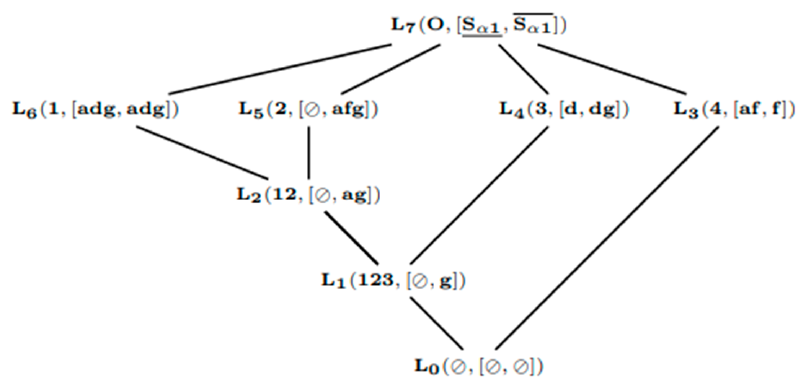
Figure 3. Reduct S α 1 . Figure 3. Reduct 𝑆 (cid:3080)(cid:2869) . Consider a reduct S α 2 = { b , c , d , g } whose corresponding concept lattice is L ( O , M , R nS Then L [ O 0 ] = ( ∅ , [ ∅ , ∅ ]) , L [ O 1 ] = ( 3, [ d , dg ]) , ( 4, [ bc , bc ]) , L [ O 2 ] = ( 1, [ bdg , bdg ]) , ( 2, [ c , bg ]) (cid:0) (cid:2) (cid:3)(cid:1) O , B , B and L ( O 3 ) = . Hence, this generates the set ( ∅ , [ ∅ , ∅ ]) , ( 123, [ ∅ , g ]) , ( 12, [ ∅ , bg ]) , ( 4, [ bc , bc ]) , ( 3, [ d , dg ]) , ( 2, [ c , bcg ]) , ( 1, [ bdg , bdg ]) and (cid:0) O , (cid:2) S and Figure 4 expressions the hasse diagram.